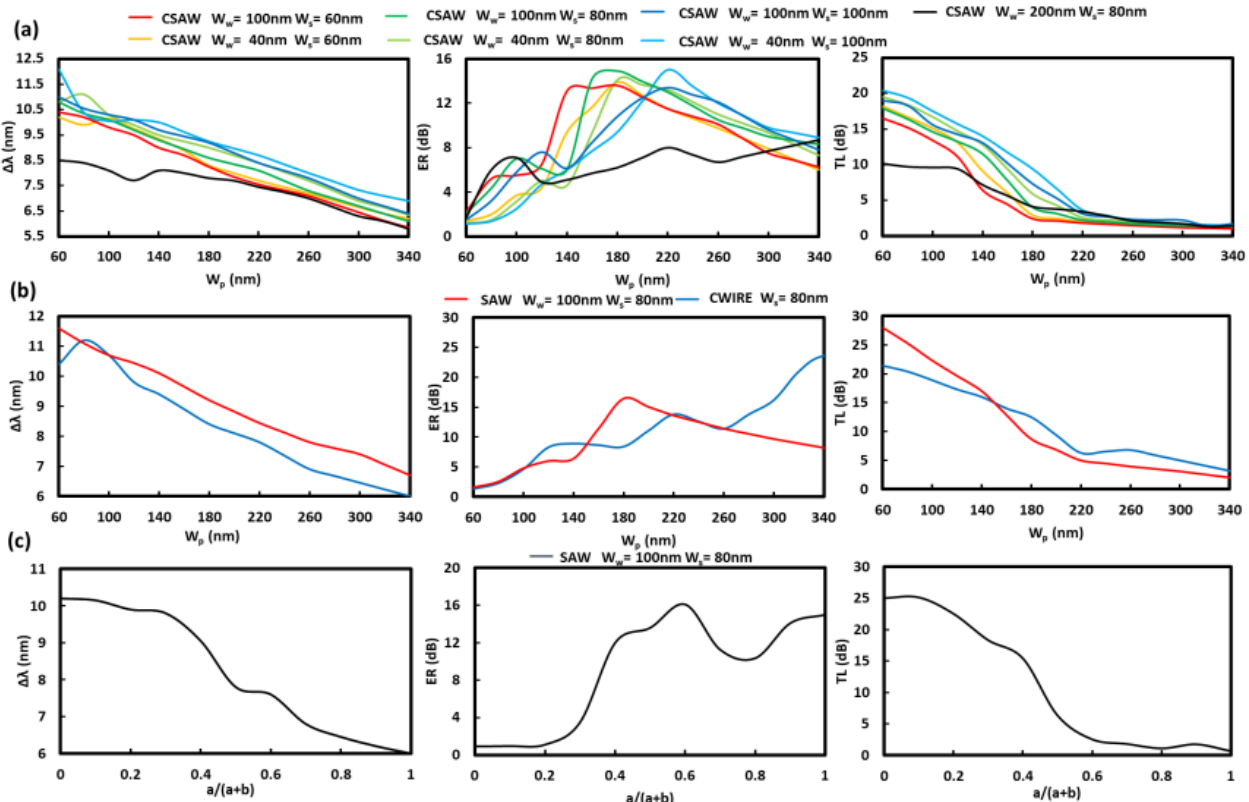
Figure 6. SAW, CSAW, and CWIRE BG RI sensors. Δλ, ER and TL dependence on ( a , b ) W p with various W s and W w values with constant values being W su = 60 nm and c = d = 100 nm or ( c ) a/(a + b) for SAW BG RI sensor and ( b ) H = 500 nm. With Λ fitted to have sensing peak at 1550 nm. The second set of simulations are for the SAW BG with W w of 100 nm and W s of 80 nm, and the CWIRE BG with W s of 80 nm for all the structures, and the results are shown